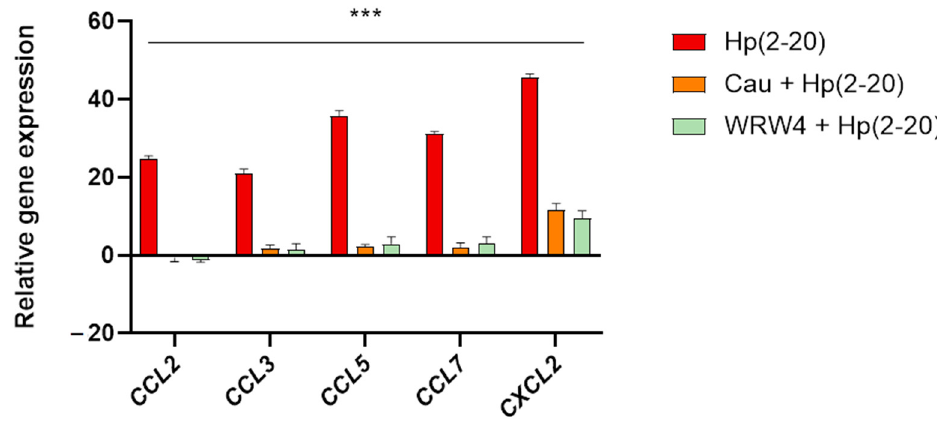
Figure 3. Cau attenuates Hp(2–20)-induced chemotactic signals. Relative genes expression of CCL2 , CCL3 , CCL5 , CLL7 and CXCL2 was determined by quantitative real time PCR (qPCR), performed on RNA isolated from AGS cells cultured with Hp(2–20) 25 µ M for 2 h and cells pretreated with Cau 15 µ M or WRW4 10 µ M for 30 or 15 min, respectively, and then cultured with Hp(2–20) 25 µ M for 2 h. All samples were normalized to GAPDH as the reference housekeeping gene. Furthermore, relative gene expression was normalized to basal activity (untreated control), in order to obtain relative fold expression. Graphs report the results of at least three independent experiments, represented as means ± SD. Statistical analysis was performed by GraphPad Prisma software, using one-way ANOVA followed by Bonferroni post hoc correction. *** p < 0.0001 (Hp(2–20) vs. Cau + Hp(2–20) and Hp(2–20) vs. WRW4 + Hp(2–20).